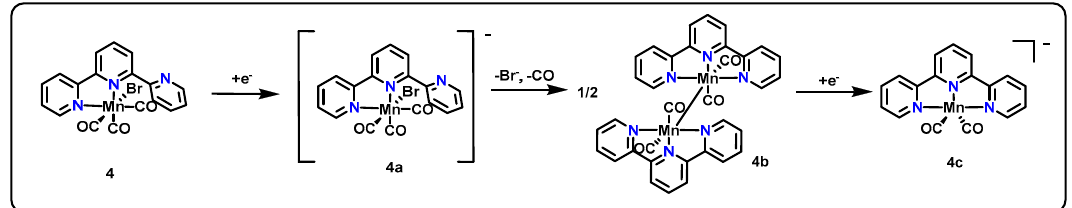
κ 3 -tpy)(CO) 3 Br ( 4 ) and Mn( 2 Br ( 5 ) [46,47]. Figure 2. Structures of Mn( κ 2 -tpy)(CO) 3 Br ( 4 ) and Mn( κ 3 -tpy)(CO) 2 Br ( 5 )